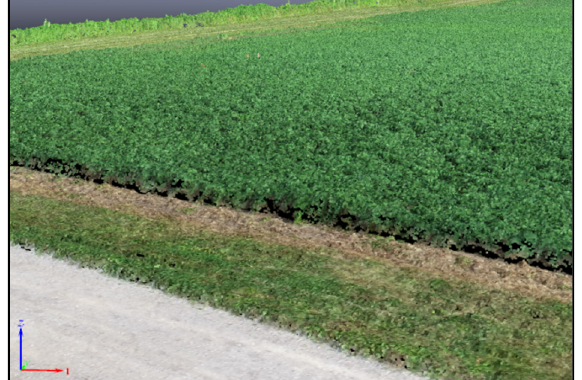
Figure 5. A side view of the alfalfa canopy in Field 1 from a portion of a fully processed model flown on 4 June 2019 using 30–90° flight parameters. Although the UAV did not take pictures from this angle and this close to the ground, the photogrammetry process captured the transition from the short grass bordering the field to the taller alfalfa plants.